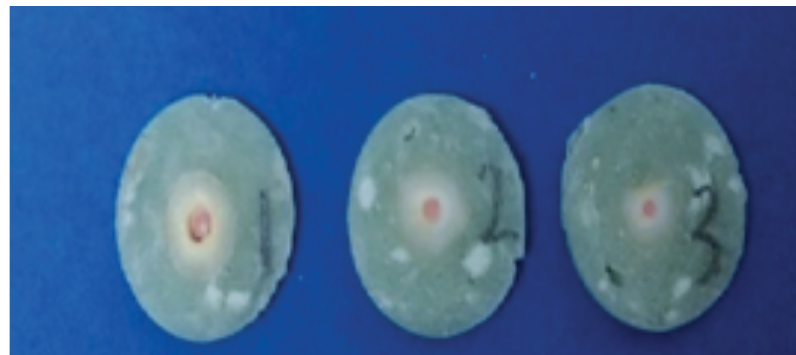
Figure 1. Sections in the coronal, middle and apical